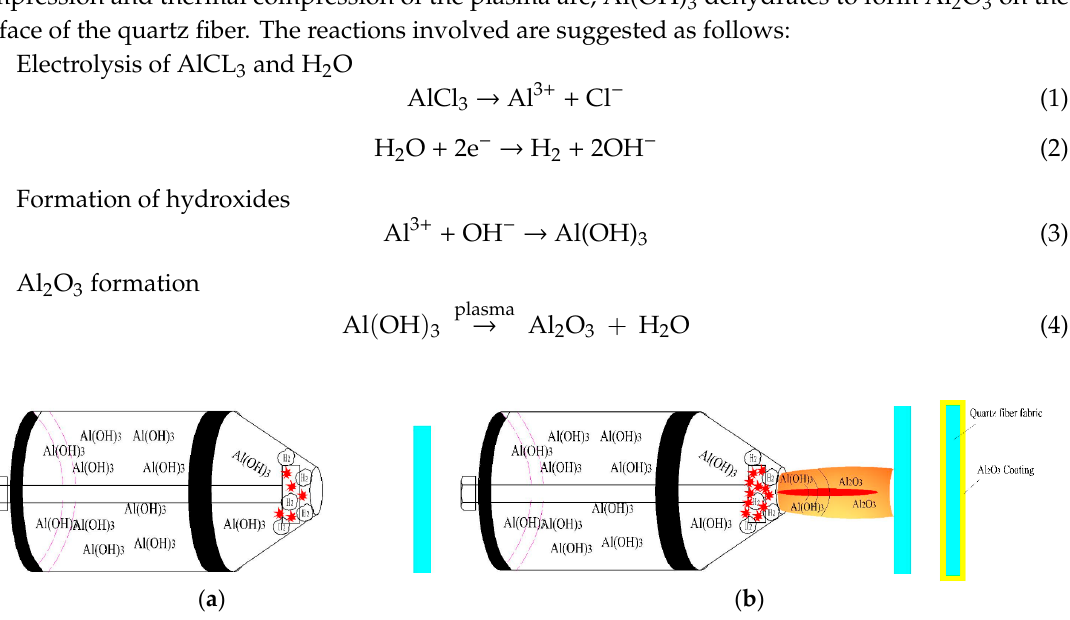
Figure 6. The schematic diagram of the formation mechanism of the Al 2 O 3 coating on quartz fiber fabric, ( a ) H 2 bubble and micro arc formation, ( b ) stable plasma jet formation, and Al 2 O 3 coating deposited on the quartz fiber.